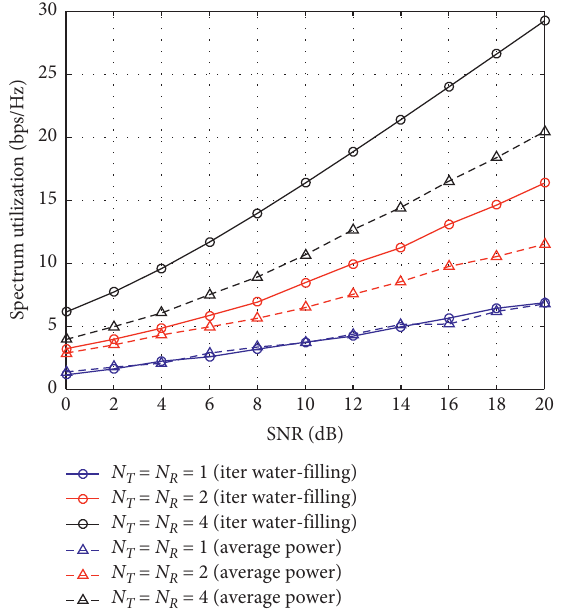
Figure 6: Spectrum utilization under different power allocation